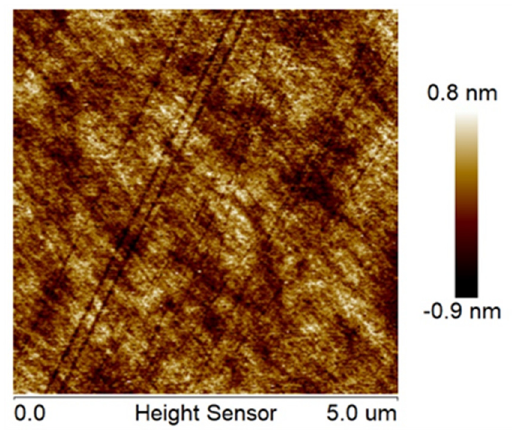
Figure 2. Schematic of plastic deformation and lateral cracks on the silicon workpiece by single abrasive at the pad–workpiece interface; d i and d i ’ denote the workpiece plastic and pad elastic de- formation depths, respectively, h is the gap between the pad and workpiece, 𝑎 (cid:3036) is the contact area radius for the abrasive and workpiece, and 𝑟 (cid:3036) is the radius of the abrasive particle.